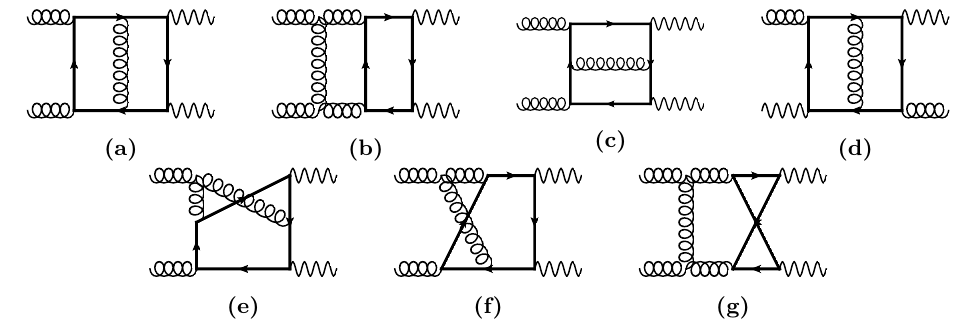
Figure 2. Representative Feynman diagrams in class A with irreducible topologies. The number of master integrals in each topology are 3, 4, 3, 3, 5, 5, and 4 respectively.